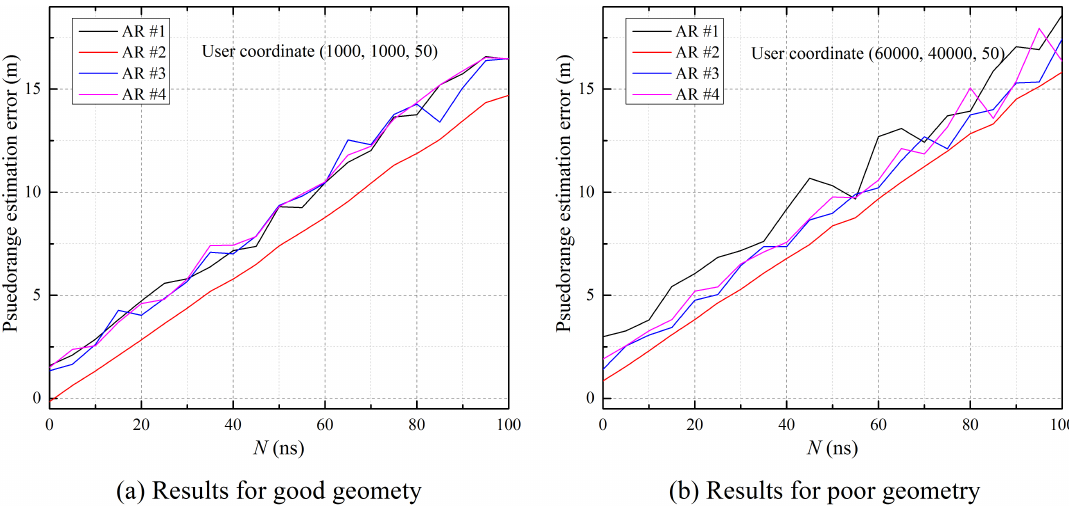
Figure 9. Error of estimated pseudorange